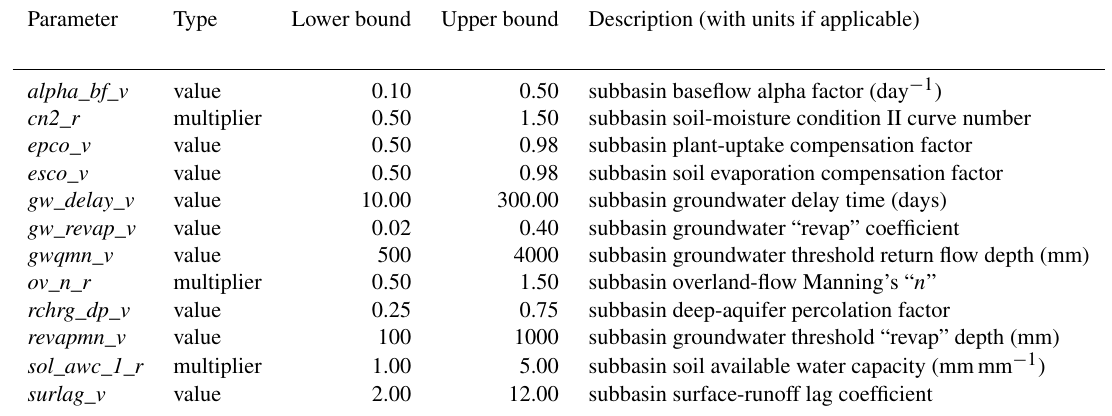
Table 1. Summary of parameters used in the reduced parameterization. These 12 inputs were selected from Table 1 in Arnold et al. (2012b) and are adjusted on the subbasin